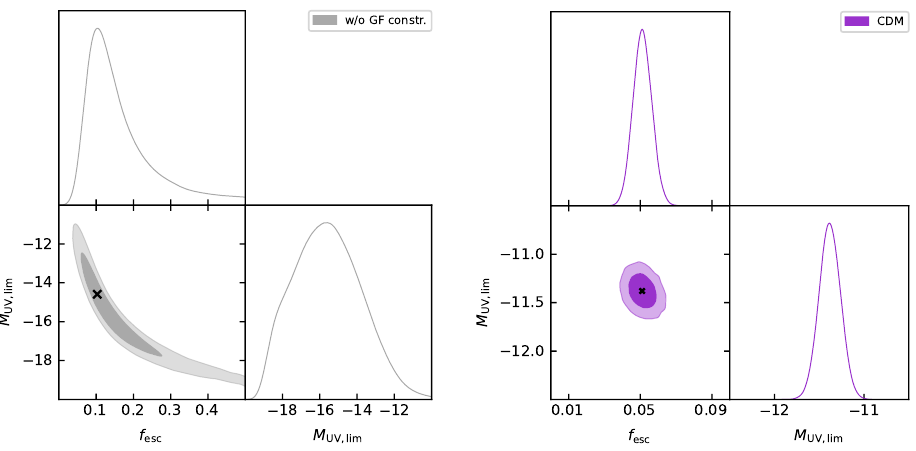
Figure 4. MCMC posterior distributions in the standard CDM scenario for the escape fraction f esc of ionizing photons and the limiting UV magnitude M UV,lim . In the left panel (grey contours/lines), the galaxy formation constraint derived via abundance matching is not included in the likelihood (see Section 2.3), while in the right panel (magenta contours/lines), this is taken into account. The contours show 68% and 95% confidence intervals, the black cross shows the maximum likelihood position, and the marginalized distributions are in arbitrary units (normalized to 1 at their maximum